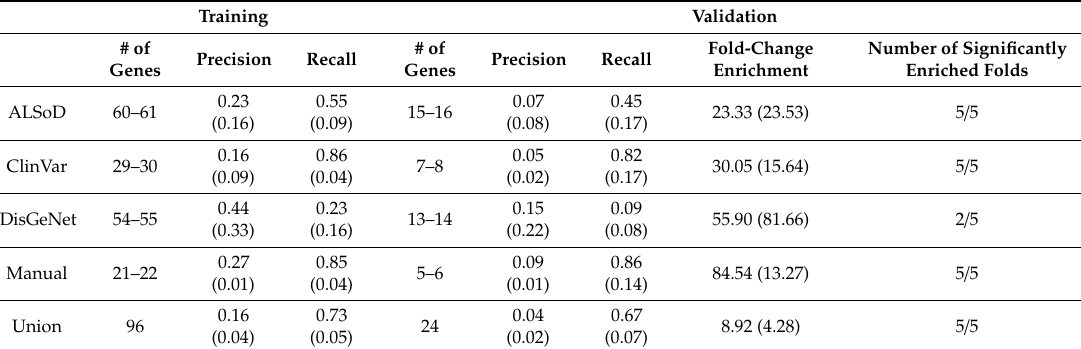
Table 1. Cross-validation performance for each definition of ALS-linked genes. Precision, recall, and fold-change enrichment are given as the mean (standard deviation) for five folds. The numbers of genes are minimum-maximum. The fold-change enrichment is based on the expected precision of random guessing. Each of the five folds is considered significantly enriched if the p -value for predicting at least as many genes correctly is < 0.05 under the hypergeometric distribution.